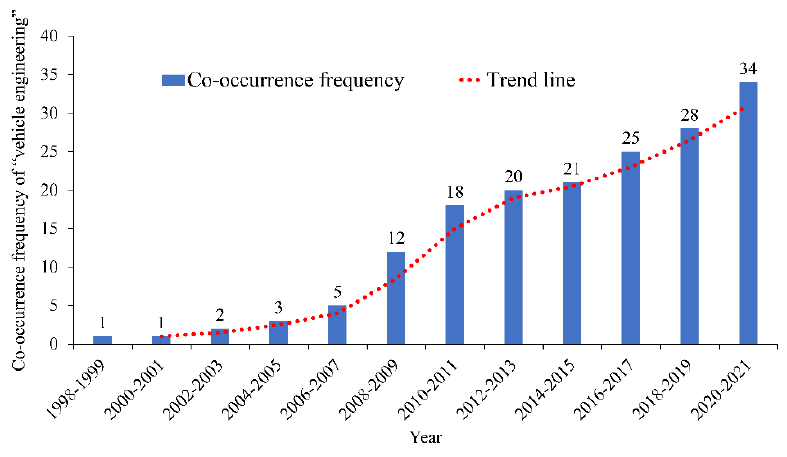
Figure 10. Co-occurrence frequency and time distribution of “vehicle engineering”.